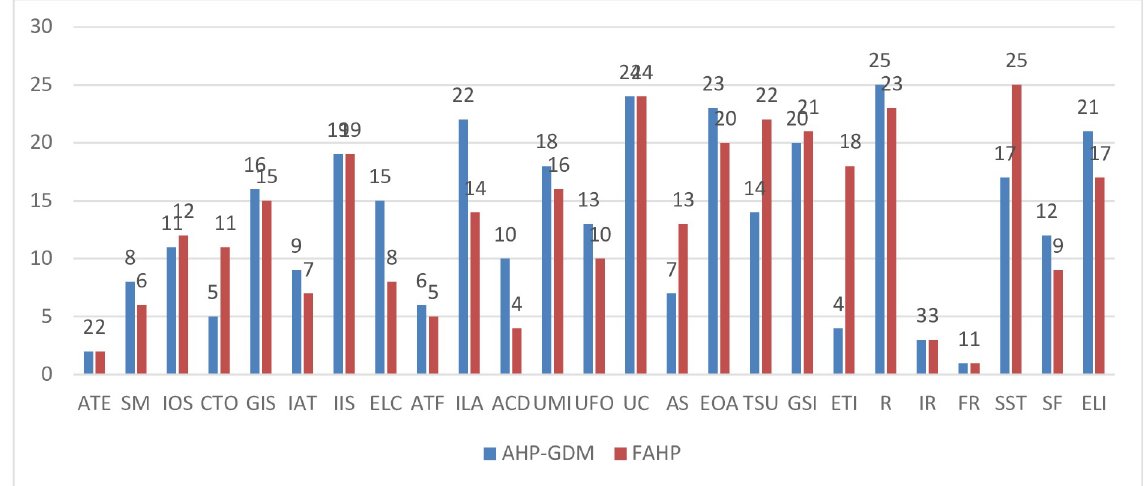
Fig 6. A comparison of ranks CSFs of E-Learning using AHP-GDM and FAHP.